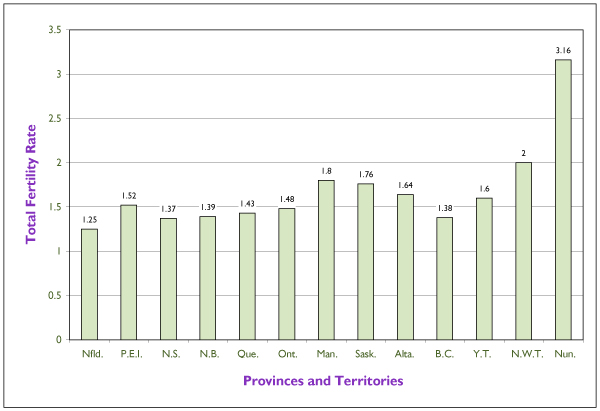
Provincial/territorial Total Fertility Rate 2000 Source: Statistics Canada, Vital Statistics